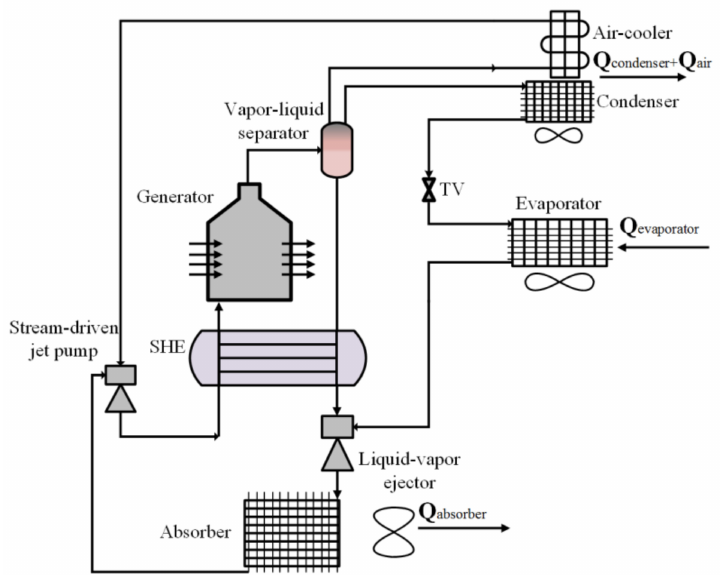
Figure 12. Schematic of ejector-driven DEARS